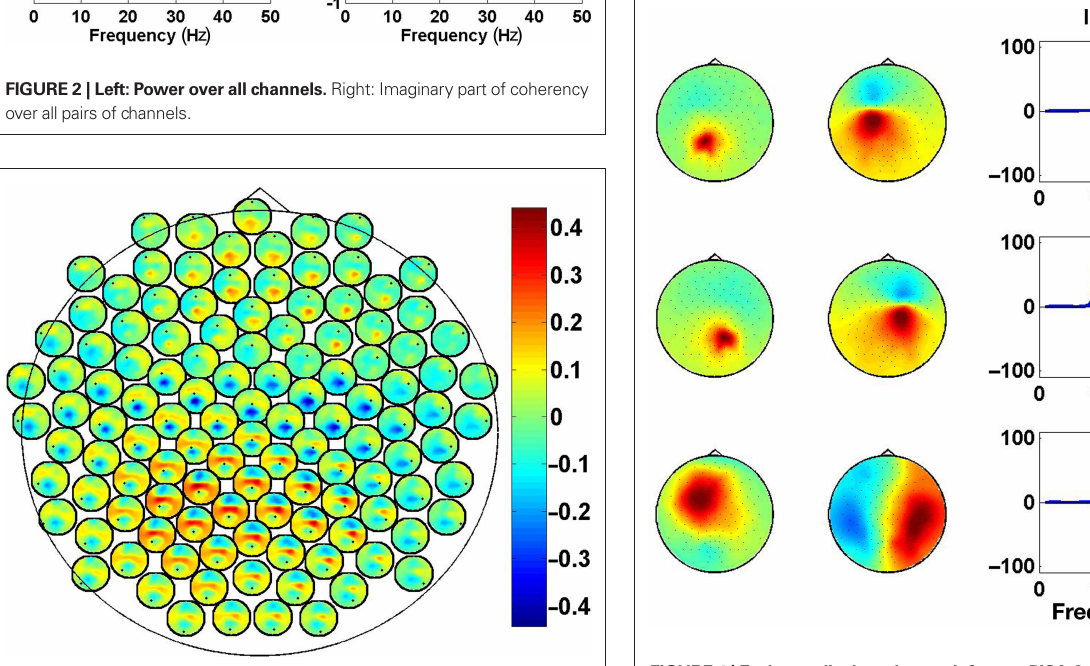
FIGurE 4 | Each row displays the result for one PISA Component. Left and middle columns show the respective topographies. Panels in the right column show the interaction as a function of